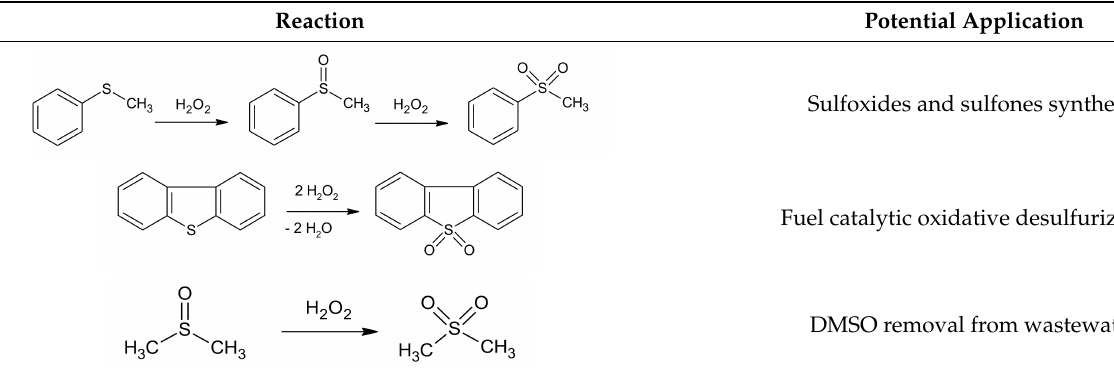
Table 1. Model sulfoxidation reactions and their